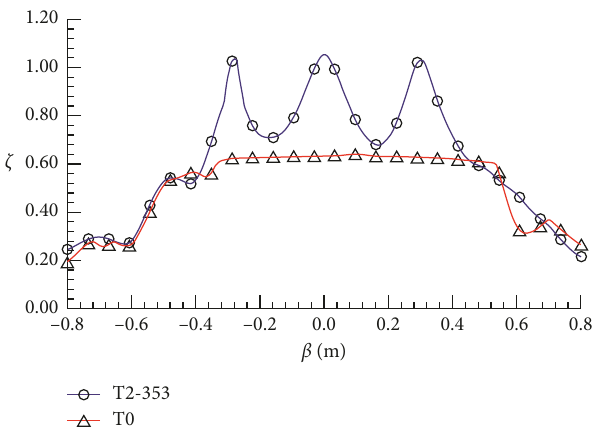
Figure 16: Variation of the dissipation rate on L